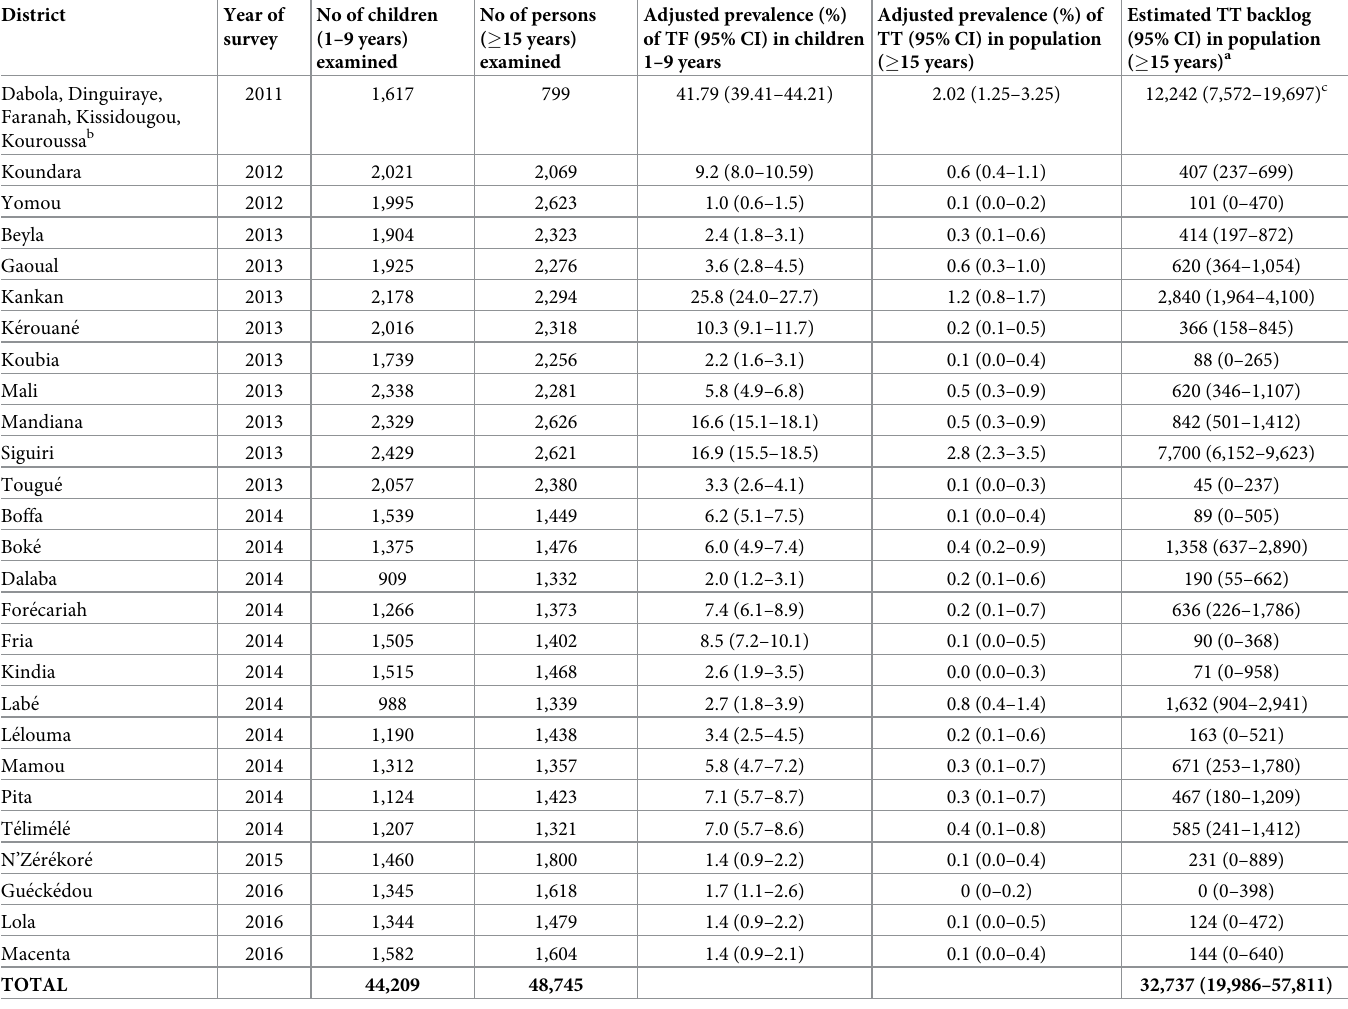
Table 2. Adjusted prevalence of TF, TT and estimated TT cases in